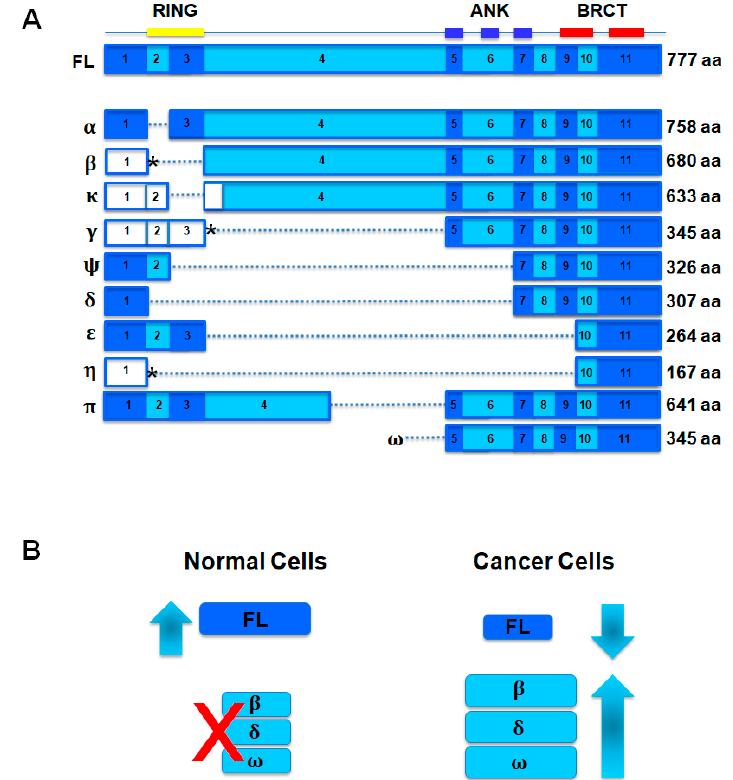
Figure 1. Structure of BRCA1-associated RING domain 1 (BARD1) and spliced isoforms. ( A ) Full-length (FL) BARD1 exon structure is aligned with spliced BARD1 isoforms below and protein structure above. The protein domains are reported at top of the figure. Splice variants are named with Greek letters (left). Presumed protein coding exons are shown in blue colors; non-coding exons are shown in white ( β , κ , γ , η ); asterisk shows alternative open reading frames ( β , γ and η ). Amino acid (aa) number is reported for FL BARD1 and BARD1 isoforms; ( B ) Model for dual role of BARD1 in cancer. In normal cells BARD1 isoforms ( β , δ , ω isoforms, discussed in “Biological Functions of BARD1 as Oncogene” paragraph) are not expressed; in cancer cells, full-length BARD1 (FL) expression (tumor suppressor role of BARD1) decreases and BARD1 isoforms expression (oncogenic role of BARD1) increases. Figure 1 has been modified from Irmgard Irminger-Finger et al. [3].